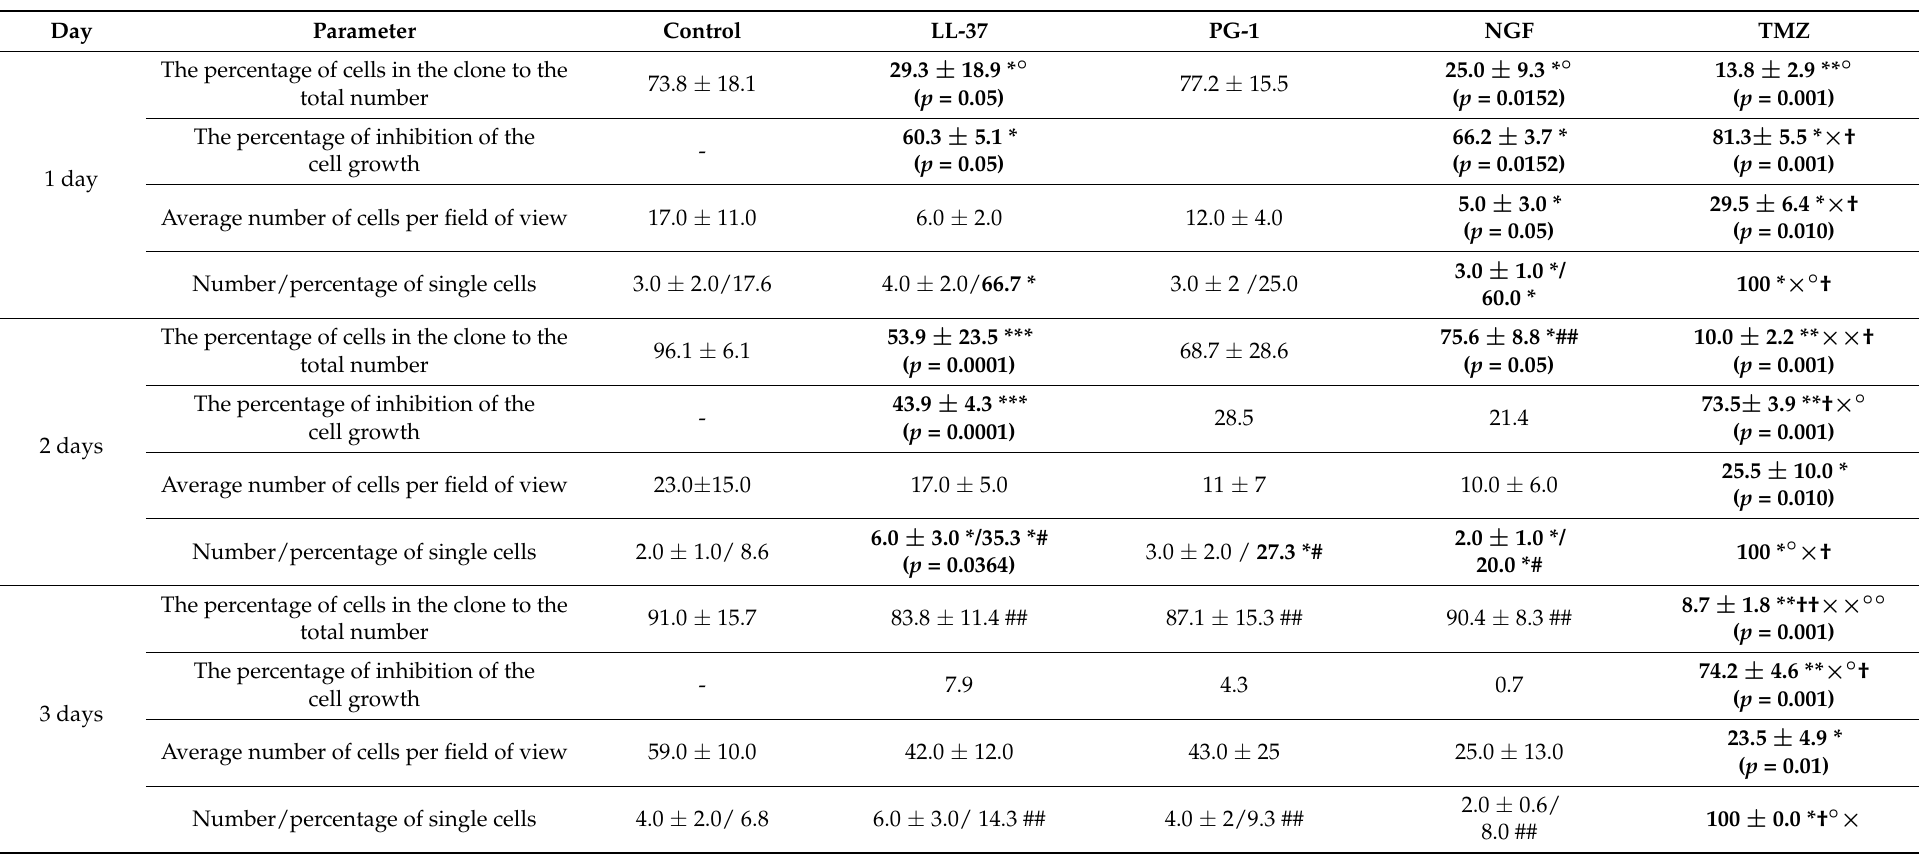
Table 1. Impact of LL-37, PG-1, and NGF on clonogenicity of U251 glioma